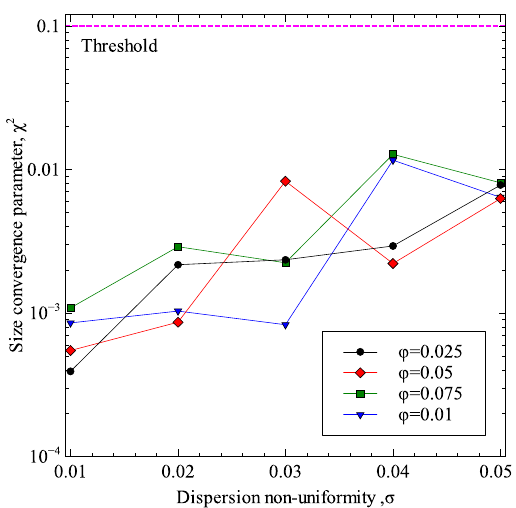
Figure 8. Verification of RVE size for computational homogenization.